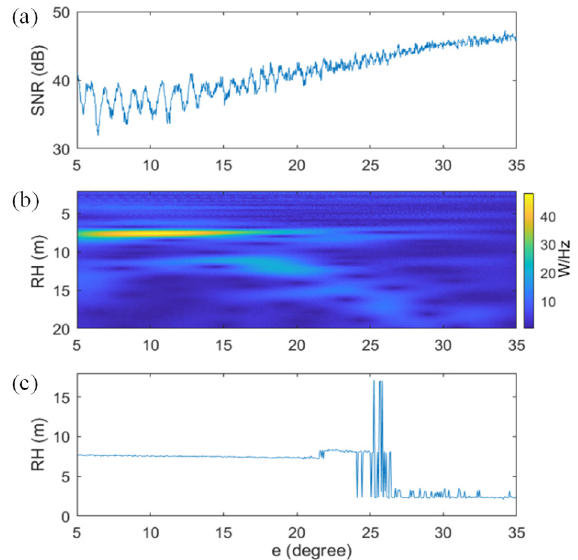
Figure 1. Wavelet spectrogram and the peak RH series of GPS L2C from PRN 3 satellite on DOY 237, 2017: ( a ) the SNR arc of GPS L2C from PRN 3 satellite on DOY 237, 2017; ( b ) the corresponding wavelet spectrogram; ( c ) the corresponding peak RH series.